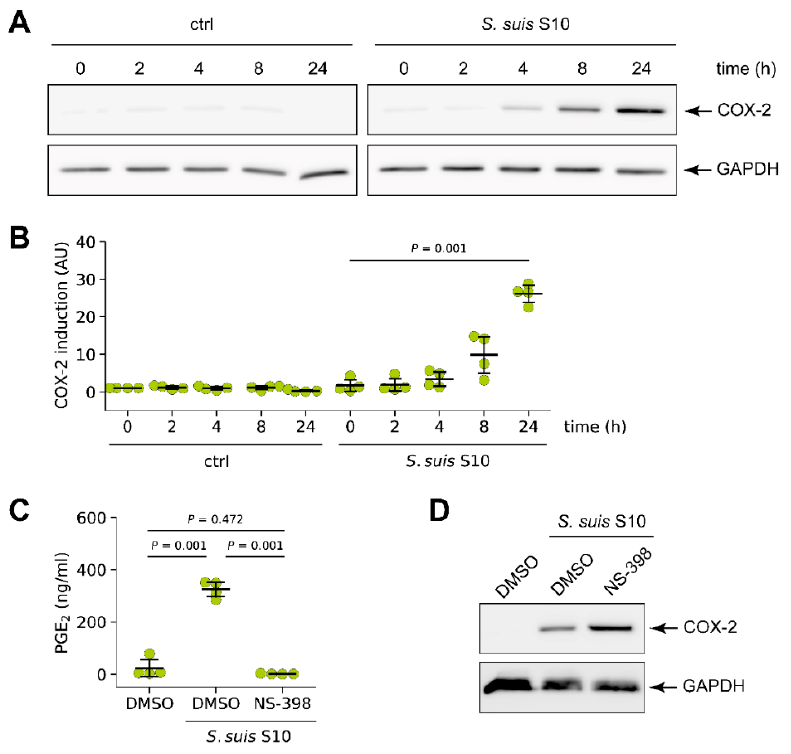
Figure 1. S. suis induced expression of cyclooxygenase-2 (COX-2) in porcine lung tissue. ( A ) Preci- sion-cut lung slice (PCLS) were left uninfected (ctrl) or infected with S. suis S10 and COX-2 protein expression was analysed 0, 2, 4, 8, and 24 h after infection by Western blotting. Glyceraldehyde 3-phosphate dehydrogenase (GAPDH) served as loading control. One representative of four inde- pendent experiments is shown. ( B ) Densitometric analysis of the Western blot experiments described in ( A ). Data are presented as mean ± standard deviation (SD) of four independent experiments. Exact p values are indicated (Welch analysis of variance (ANOVA) followed by Games–Howell post hoc test). ( C ) PCLS were infected for 24 h with S. suis S10 in the presence of vehicle (DMSO) or the selective COX-2 inhibitor NS-398 (10 µM). Cells treated with vehicle (DMSO) alone served as control. Prostaglandin E 2 (PGE 2 ) production was determined in the supernatant by ELISA. Data are presented as mean ± SD of four independent experiments. Exact p values are indi- cated (Welch ANOVA followed by Games–Howell post hoc test). ( D ) Western blot analysis of COX-2 induction in PCLS treated and infected as described in ( C ). GAPDH served as loading con- trol. One representative of three independent experiments is shown.